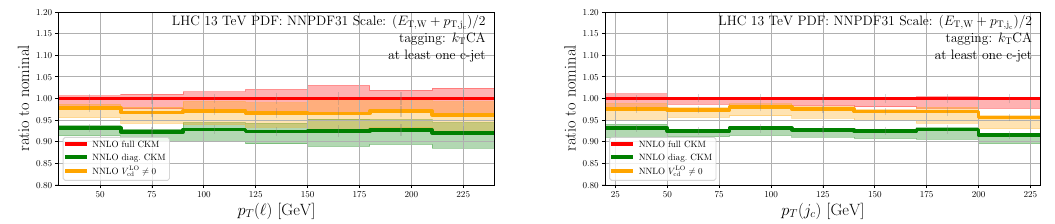
Figure 3 . Ratios of differential distributions in the transverse momentum of the charged lepton (left) and the charm jet (right) for the process pp → W + j QCD predictions including only diagonal CKM elements (green) and the V LO only (orange), normalised to the prediction with all off-diagonal CKM elements included